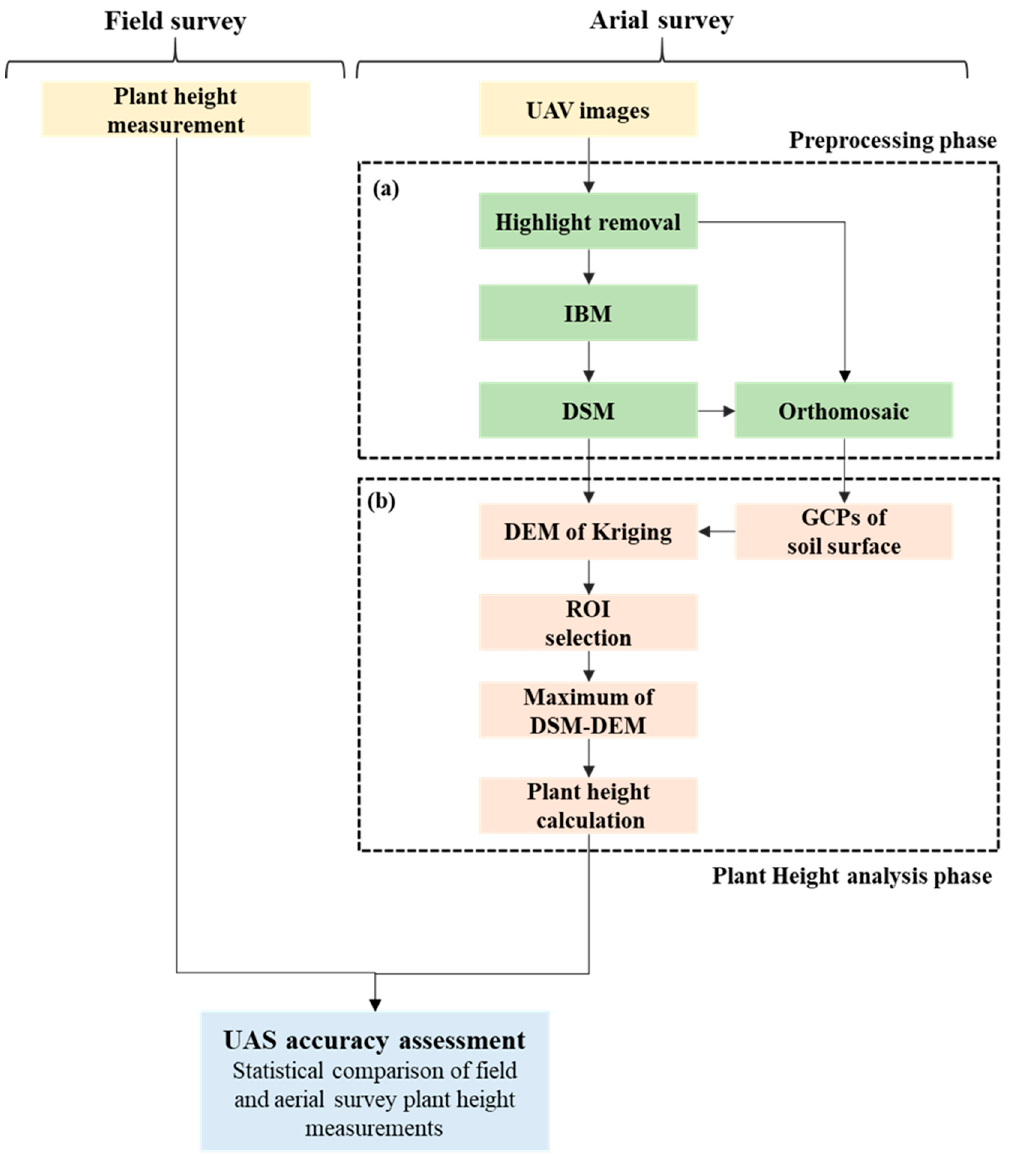
Figure 4. Workflow of plant height generated by UAV images including ( a ) DSM generation and ( b ) plant height model generation.